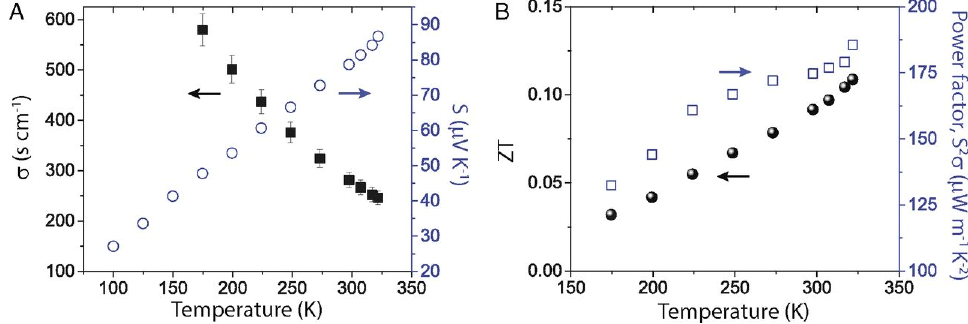
Figure 26. ( A ) Electrical conductivity and Seebeck coefficient variation with temperature, ( B ) Power factor and figure of merit variation with temperature. Reproduced with permission [21]. Copyright